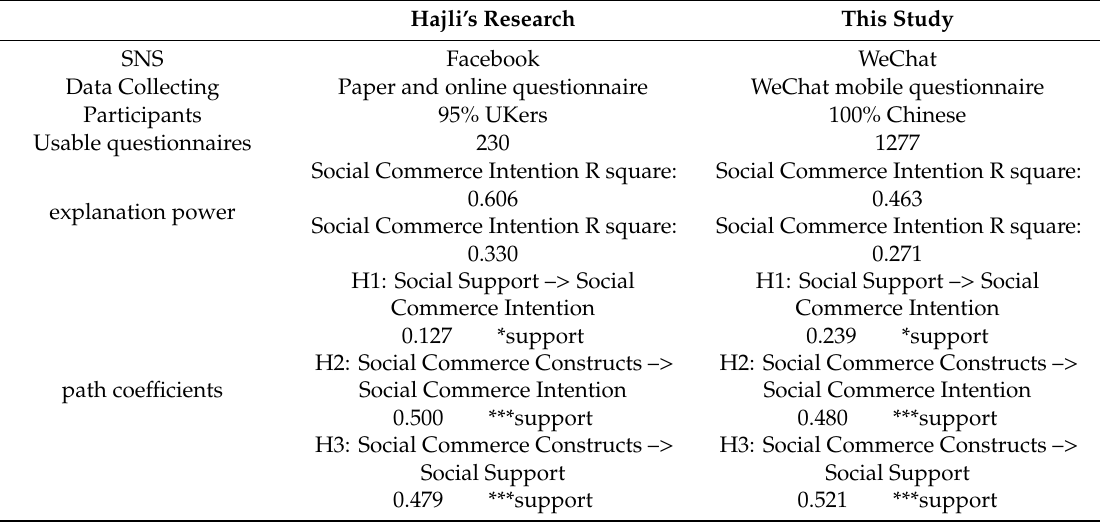
Table 6. The comparison between Hajli’s research and this